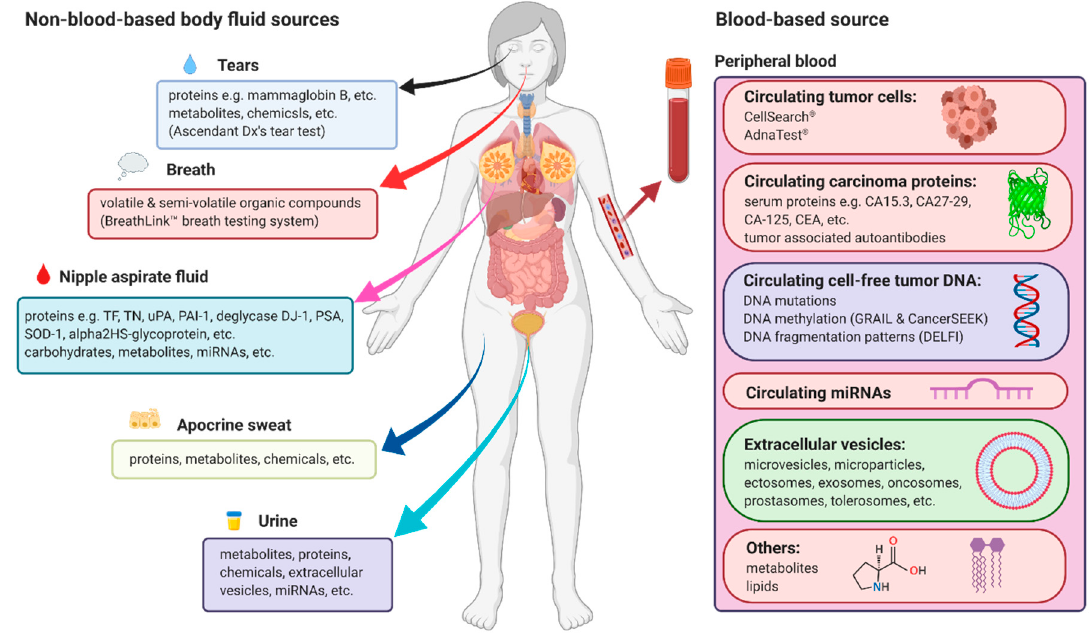
Figure 1. Overview of current sources and main measurement types of non-invasive biomarkers for early detection of breast cancer. Figures were created with BioRender.com (https://biorender.com/).